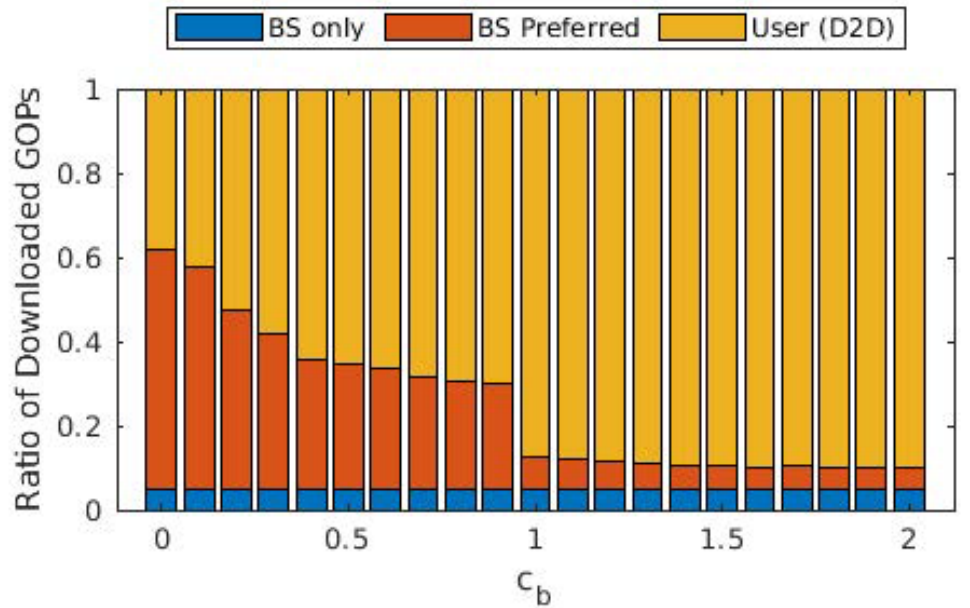
Figure 7. Ratio of the GOPs downloaded from the cloud/base station and GOPs downloaded from other users for different values of c b .